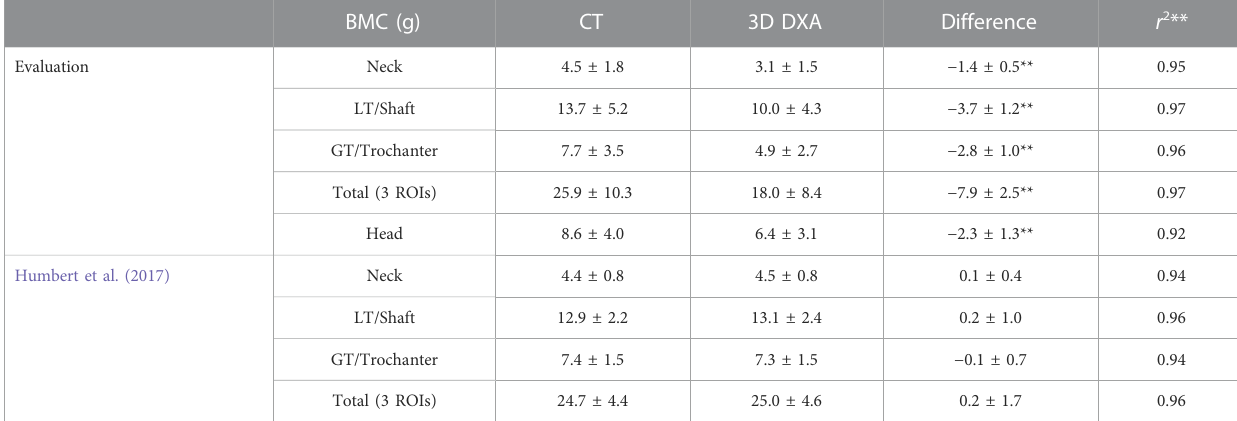
TABLE 4 Mean and standard deviation of the integral BMC results (g). The content differences and correlation coef fi cients associated with p -values < 0.01 are marked with two stars. The remaining differences were associated with p -values > 0.05. LT and GT stand for lesser and greater trochanter, respectively, and were named shaft and trochanter by Humbert et al.